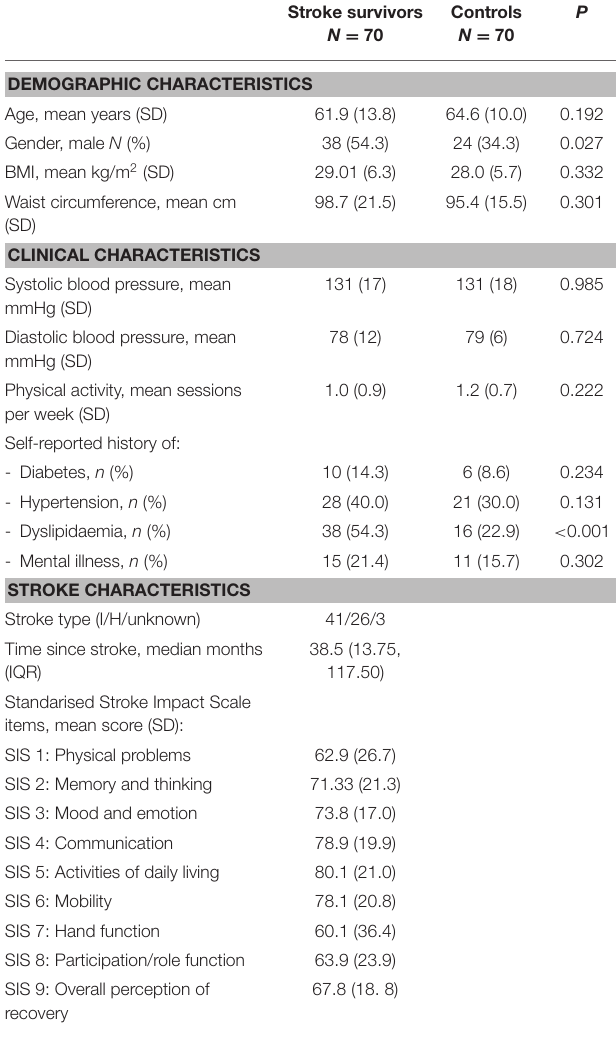
TABLE 1 | Comparison of demographic and clinical